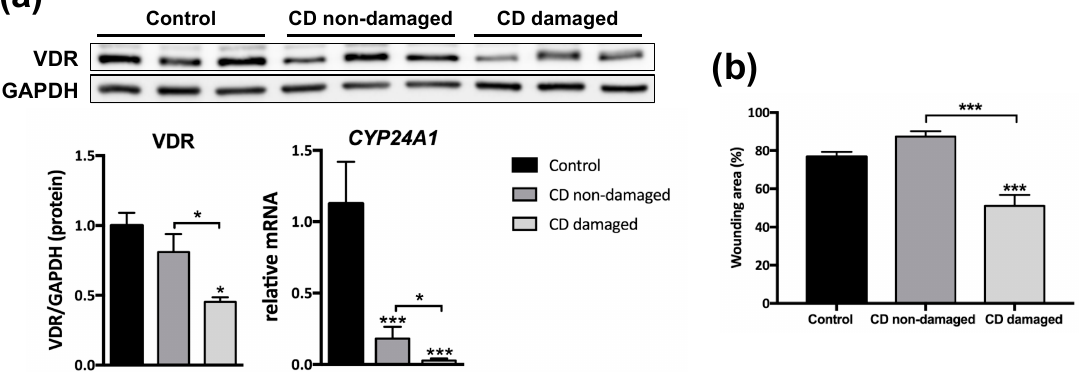
Figure 2. Reduced VDR expression and a higher migration rate in intestinal fibroblasts of CD patients. ( a ) A Western blot showing protein levels in fibroblasts isolated from non-damaged tissue of control patients ( n = 3) and non-damaged and damaged tissue of CD patients ( n = 3). Graphs show protein expression vs. GAPDH or the relative mRNA expression of CYP24A1 gene vs. β -actin in control ( n = 4) and CD ( n = 7) fibroblasts. In all cases, data are represented as fold induction vs. control fibroblasts. ( b ) The graph represents percentage of the wounding area (time 0, 100%) at 48 h in fibroblasts from control, CD non-damaged and CD-damaged tissue treated with medium iFBS-free. In all cases, bars in graphs represent mean ± s.e.m., and significant di ff erences vs. the control group or vs. the non-damaged CD (connecting lines) are shown by * p < 0.05 or *** p < 0.001.